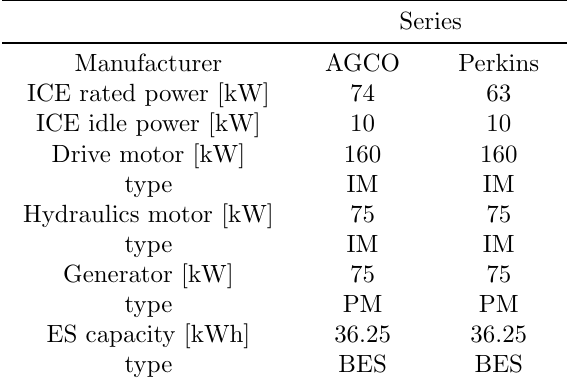
Table 5: The component dimensions of the under- ground loader